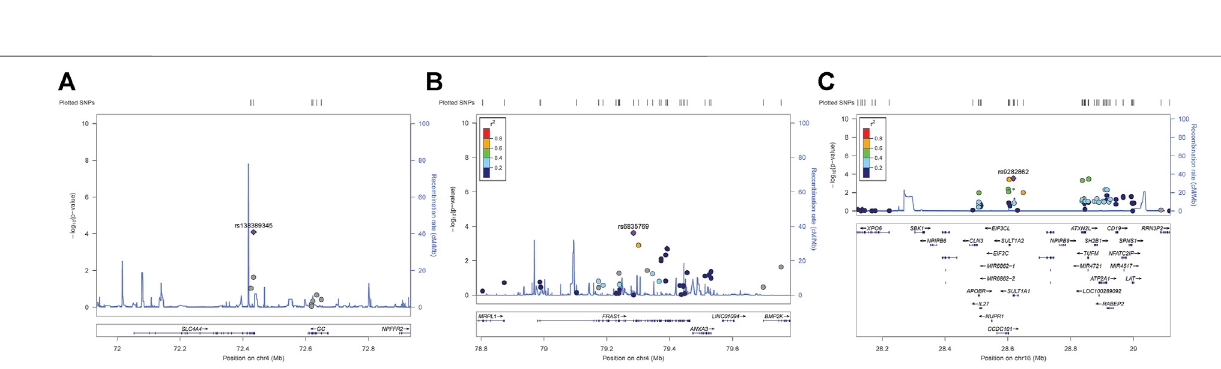
FIGURE1| RegionalassociationplotsofsuggestiveSNPsonAUC 0 – t oftotaldabigatran. (A) SLC4A4 SNPrs138389345 (B) FRAS1 SNPrs6835769 (C) SULT1A SNP rs9282862. Annotation: SNPs are shown according to their physical location and – log 10 p -values for association. Also shown is the recombination rate in centimorgans per megabase (blue line) and the linkage disequilibrium ( r 2 ) of each SNP with the SNP having the lowest p -value.